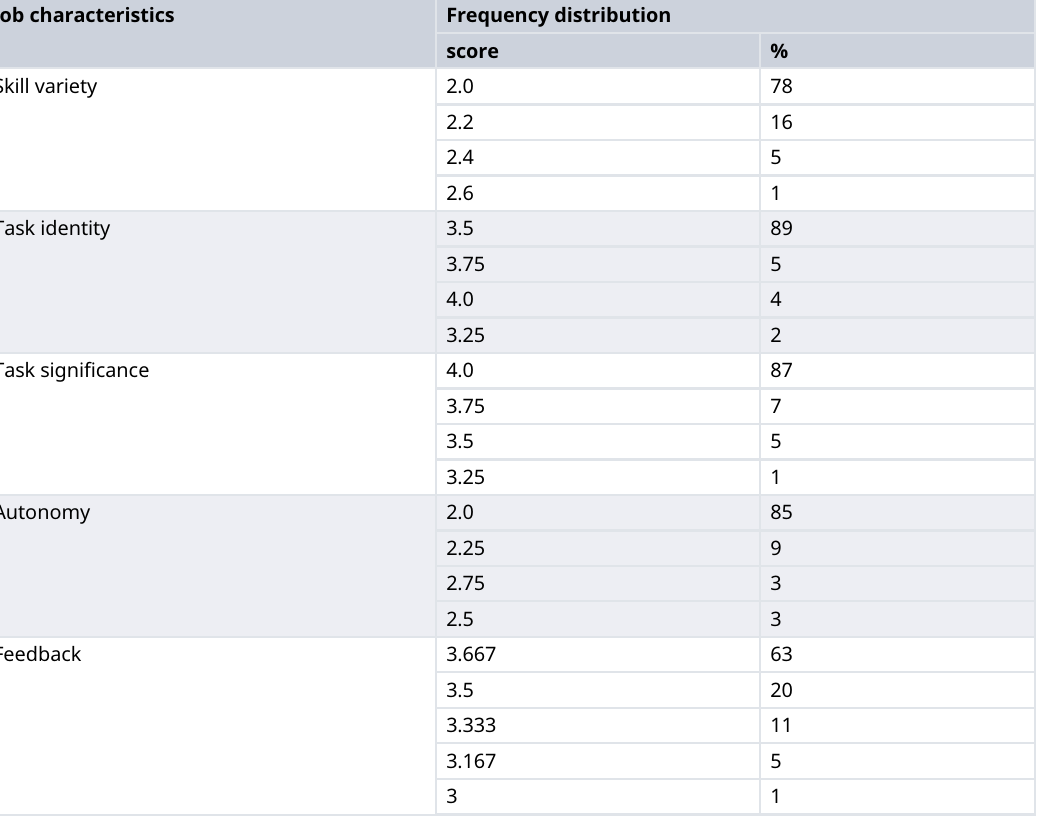
Table 4. Job characteristics score distribution.